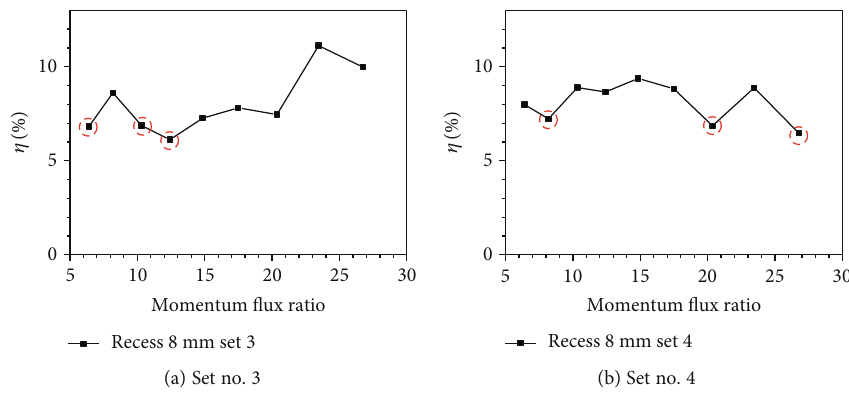
Figure 7: Damping factors for various test conditions in (a) set no. 3 and (b) set no. 4.